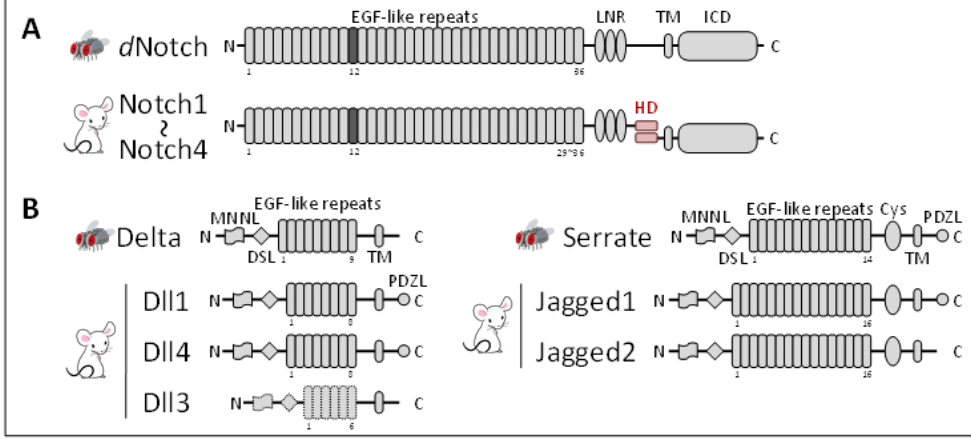
Figure 1. Notch family members in flies and mammals. ( A ) Flies have one Notch receptor, while mammals have four (Notch1-Notch4) with different numbers (36, 36, 34, and 29, respectively) of EGF repeats [16–23]. Most of mammalian Notch receptors are expressed as furin-processed heterodimers, while most surface d Notch is the unprocessed full-length form [29–32]. The core ligand-binding site of d Notch and mammalian Notch1 is located within the 12th EGF repeat [41], while other EGF repeats also contribute to ligand binding [13,42–46]. Many EGF repeats, including the 12th, bind to Ca 2+ ions, which are critical for protein structures and ligand binding [47–49]. Notch receptors form a dimer, or even a multimer, on the cell surface [50–52]. The ICD contains several domains that mediate nuclear translocation, interactions with CSL ( i.e. , Ankyrin repeats), and transcriptional activity (not depicted). LNR, Lin12-Notch repeats, HD, heterodimerization domain, and TM, transmembrane domain; ( B ) DSL ligands have a conserved N-terminal MNNL (module at the N-terminus of Notch ligands) domain, followed by a DSL domain and multiple tandem EGF-like repeats. MNNL, DSL, and the first three EGF repeats are all required for receptor binding [45,53–58]; however, other domains may also contribute to receptor binding [55,59]. Serrate is distinguishable from Delta by its larger number of EGF repeats and the presence of an additional cysteine-rich region (Cys). Some ligands have an intracellular PDZL (PSD-95/Dlg/Zo-1-ligand) motif that mediates interaction with PDZ-containing scaffold/adaptor proteins [60].